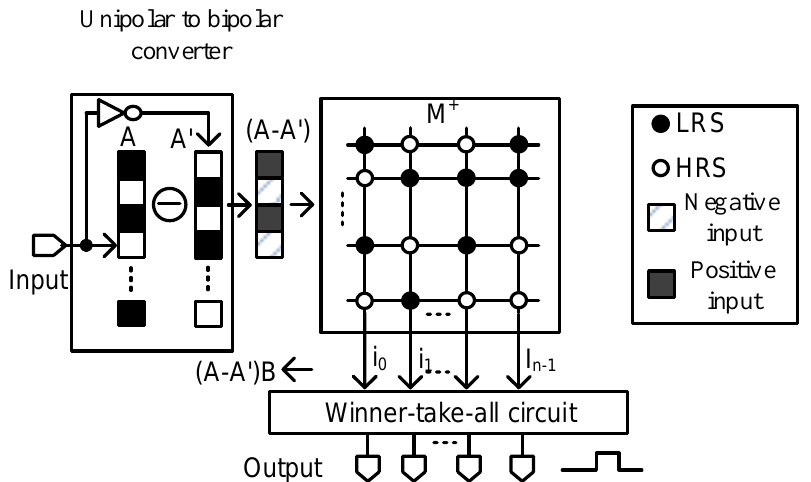
Figure 3. The single crossbar architecture for image recognition (Reproduced with permission from [16], published by IEEE).